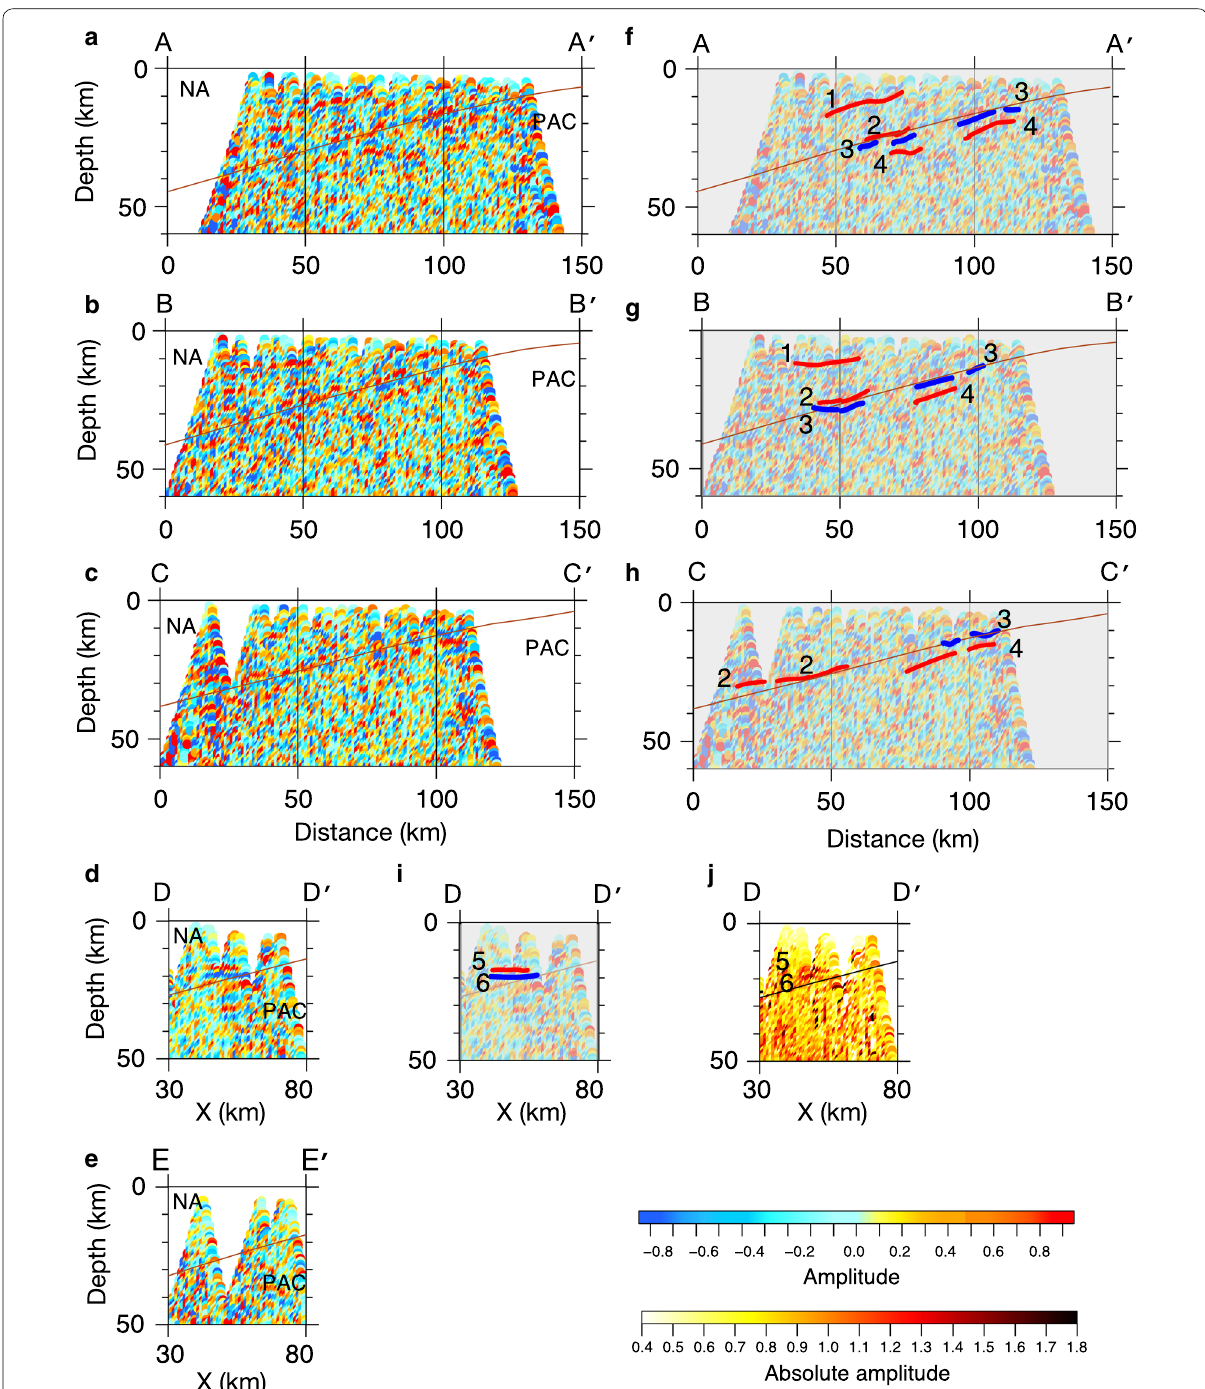
Fig. 9 Depth-domain RFs. The locations of each section are defined as in Fig. 4. Red represents positive RF amplitudes, indicating a velocity increase downwards, while blue represents negative RF amplitudes, indicating a velocity decrease downward. The brown line indicates the depths of the upper boundaries of the PAC (Nakajima et al. 2009). The RF sections in a – c were made from OBSs that were in the area where the PHS is not present (Uchida et al. 2009), and the sections in panels f – h show the major emphatic phases. The RF sections in d and e were made from OBSs only north or south of 35°N, respectively, in the area where the PHS is subducted. The section in panel i shows the major emphatic phases in d . The RF section in j was made from the same OBSs as that in d , but its RF amplitudes are shown as absolute values. Interpretations of the interfaces are as follows: (1) Conrad in the NA, (2) Moho in the NA, (3) the plate boundary between the NA and the PAC, (4) the oceanic Moho in the PAC, (5) the bottom of the low-velocity anomaly in the NA, and (6) the plate boundary between the NA and the